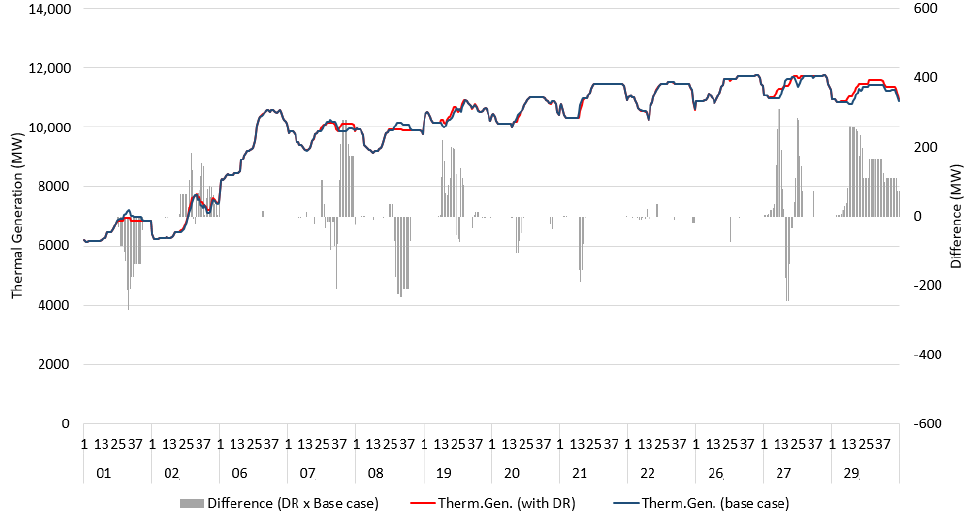
Figure 9. Total system thermal generation.